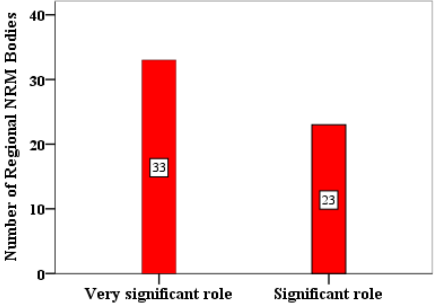
Figure 4. Role of spatial information to address